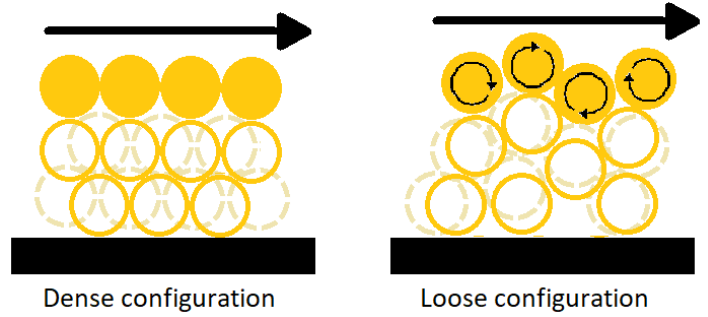
Figure 1. Cutting bed configuration types.